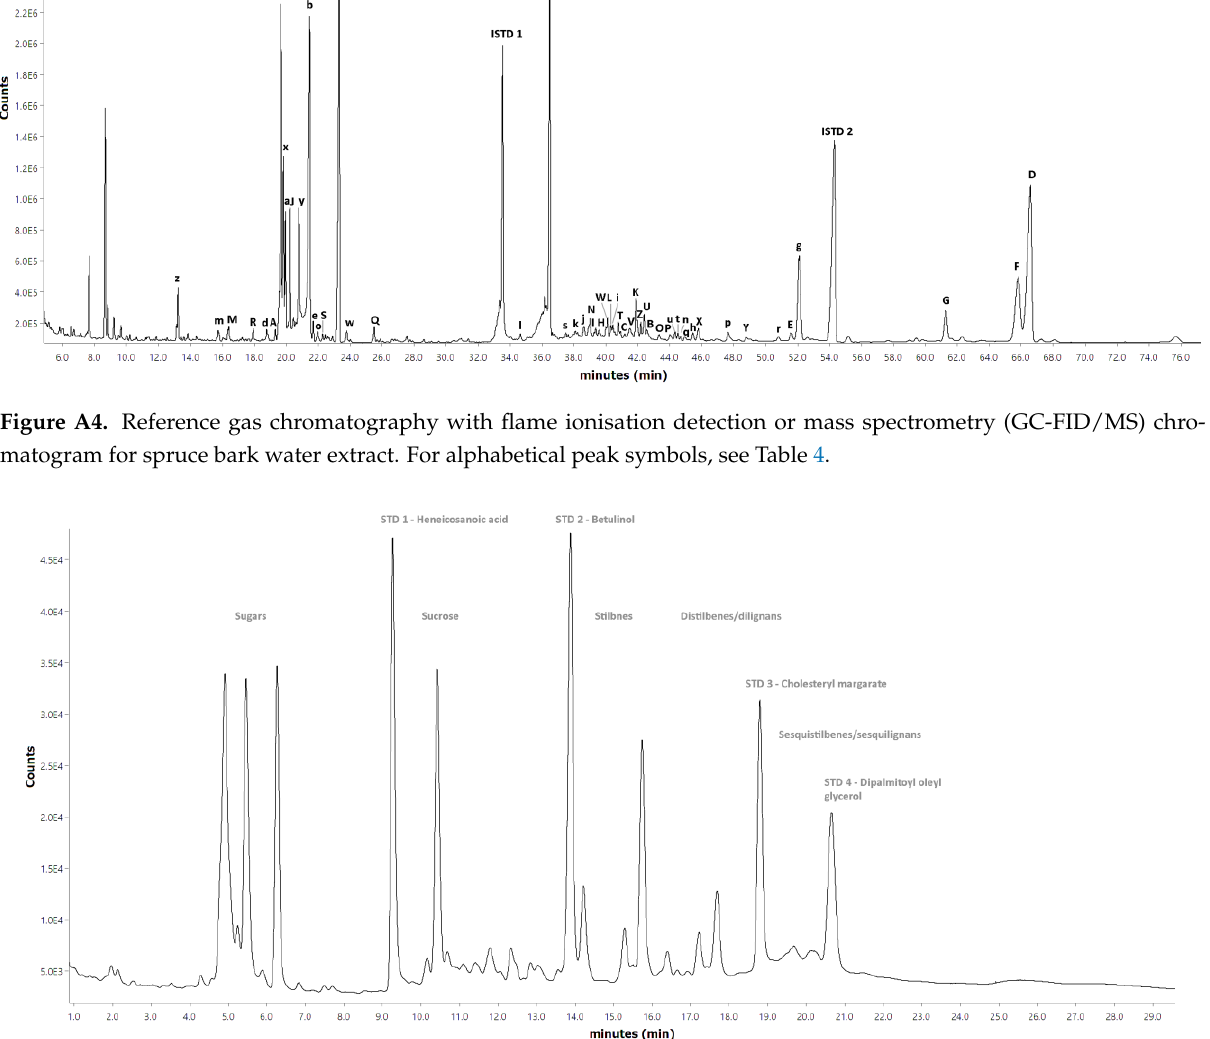
Figure A5. Reference gas chromatography with flame ionisation detector (GC-FID; short-column) chromatogram for spruce bark water extract.